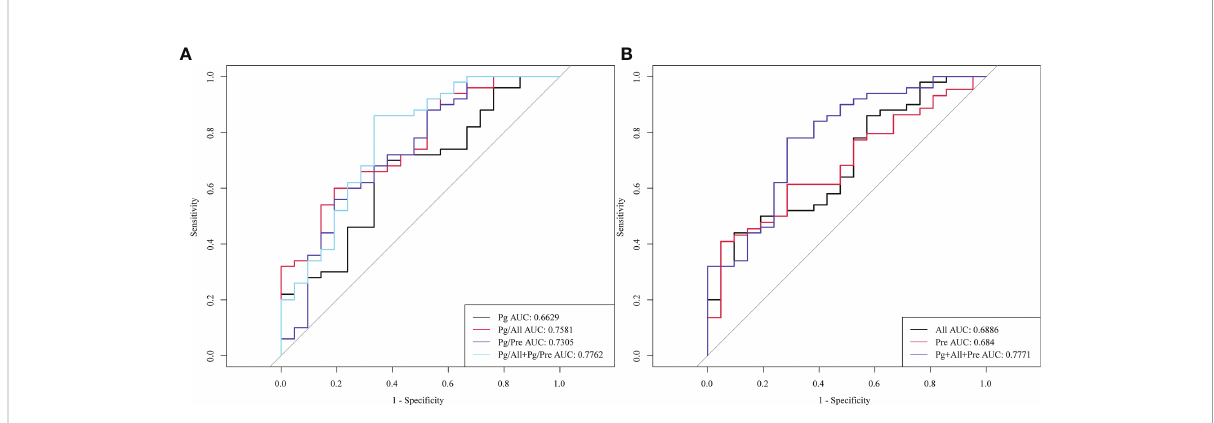
FIGURE 6 Diagnostic performance of the salivary microbial ratios Pg/All and Pg/Pre alone or in combination for detection of early ESCC. ROC curves for the diagnostic strength to distinguish stage I+ II ESCC patients from HCs for (A) Pg , the ratio of Pg/All , the ratio of Pg/Pre , and the combination of Pg + Pre + All ; and for (B) All , Pre , and both the Pg/All and Pg/Pre ratios